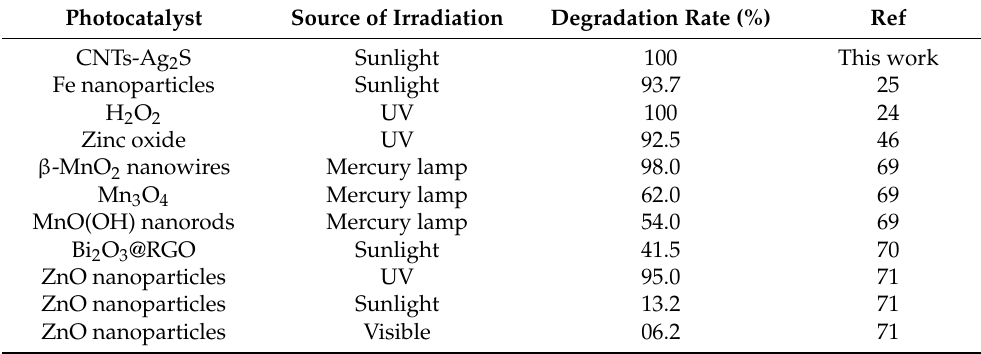
Table 3. Comparison of the degradation rate of AYR by CNTs-Ag 2 S with reported photocatalysts. Photocatalyst Source of